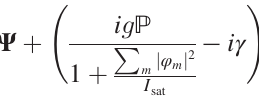
¼ 1 , Ω ¼ 100 , I ¼ 1 , f sat